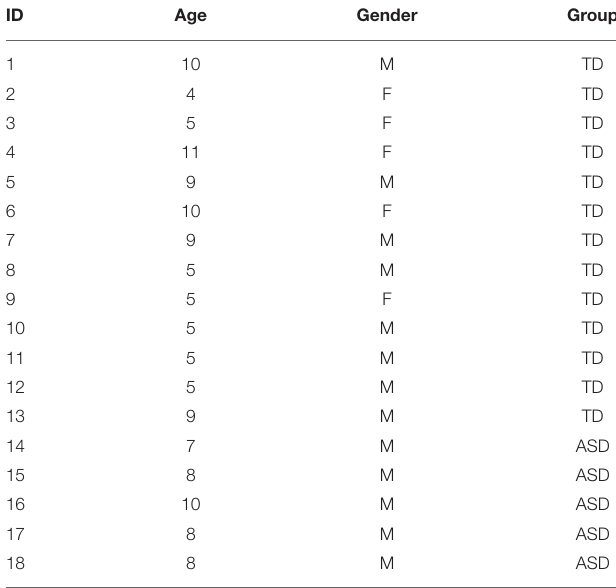
TABLE 2 | Demographic details of the